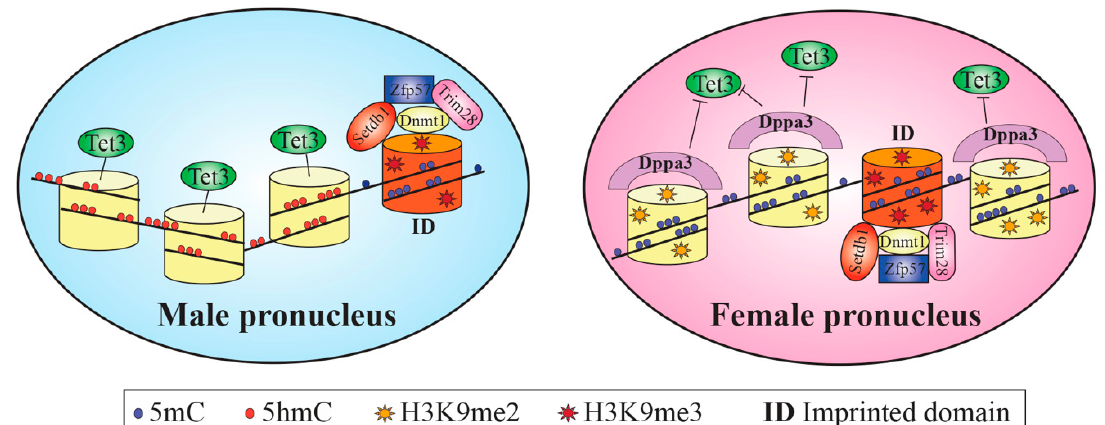
Figure 2. Schematic representation of epigenetic reprogramming occurring in the male and female pronuclei. The male pronucleus undergoes an active, almost global, erasure of DNA methylation, mainly achieved through the Tet3 enzyme, with the exception of imprinted loci. The presence of high levels of histone H3K9me2 together with the presence of Dppa3, which reduces the affinity of Tet3, protects the female genome from active demethylation. Trim28, Stedb1 and Zfp57 form a complex that protects imprinted domains; Dnmt1 allows the maintenance of cytosine methylation during DNA replication.